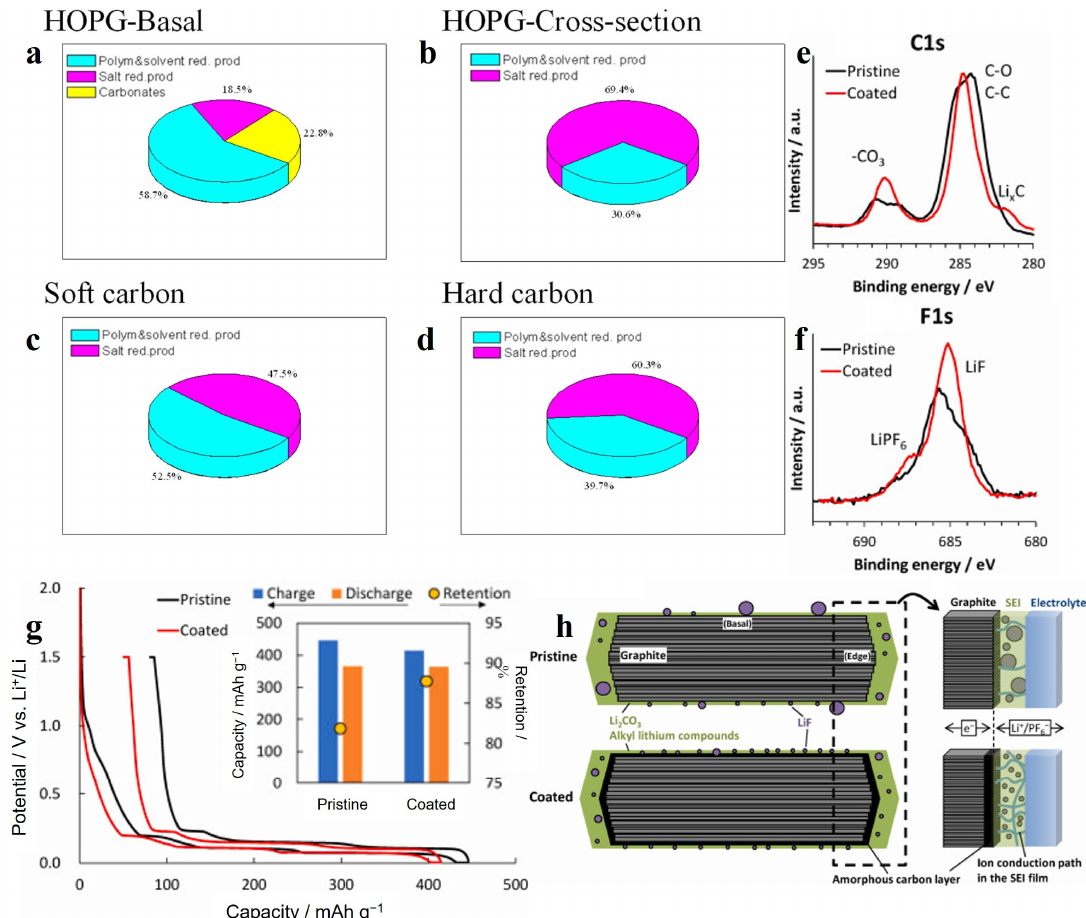
Figure 3. ( a – d ) Estimated composition of the SEI on HOPG, soft and hard carbon in LiPF 6